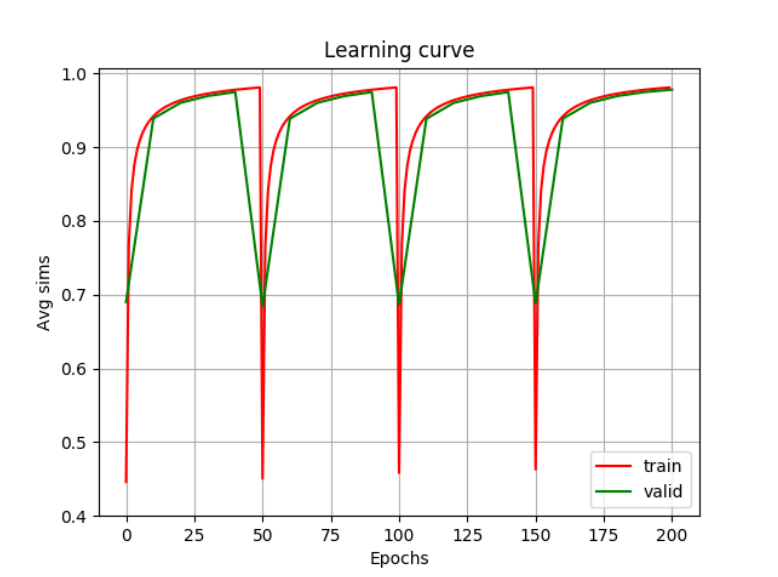
Figure 2. Learning curve of experimenting with SVD after every n th epoch (svd_mode = 1).